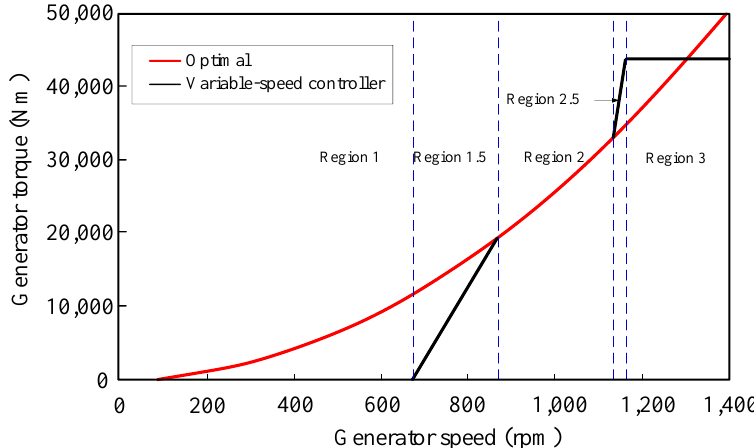
Figure 9. Relationship between generator torque and generator speed for the baseline control sys- tem.